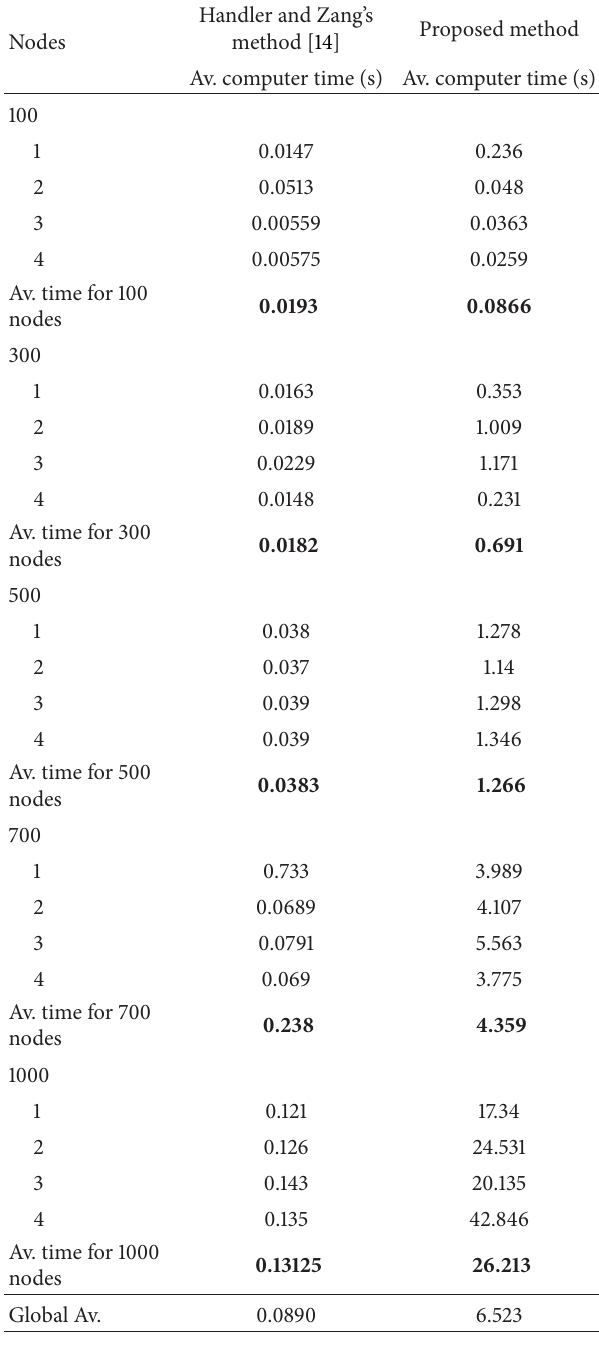
Table 5: Computational